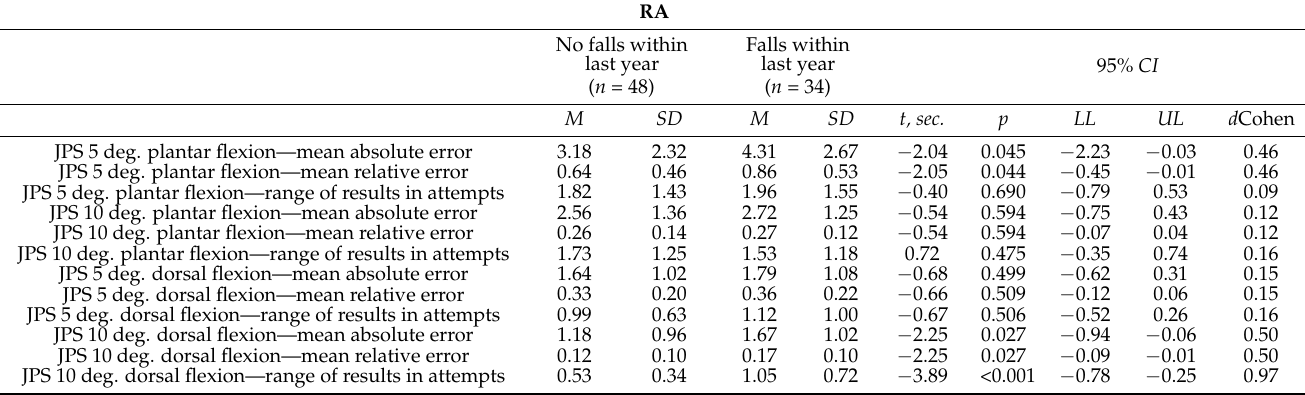
Table 6. Comparison between results of JPS between patients with falls and without falls in the group with RA and with OA.